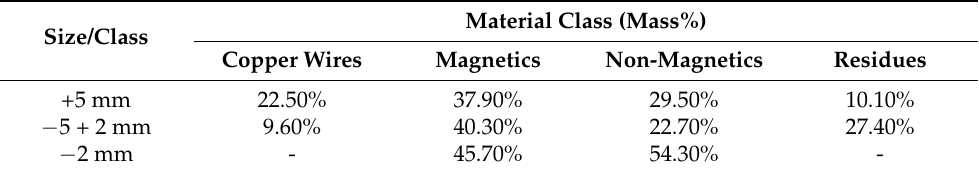
Table 2. Distribution of different material classes in the +2.8 g/cm 3 range.